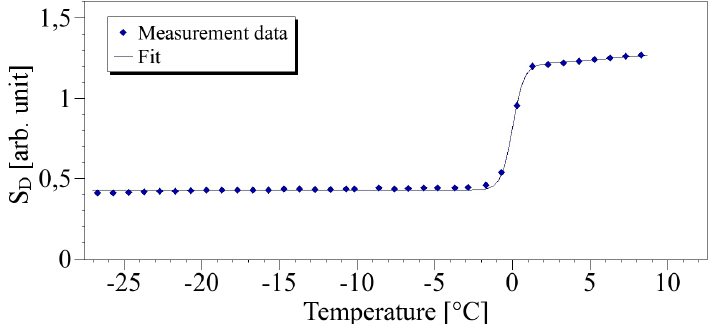
Figure 3. Points: data of pure water – Line: Fit with the modified Boltzmann equation (Equation